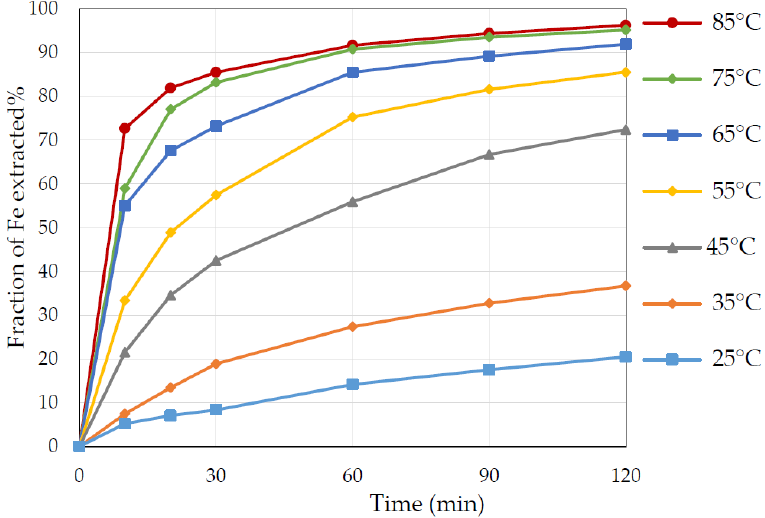
Figure 5. The extraction of iron from pyrite at different temperatures from 25 to 85 °C. Conditions: 3 M nitric acid, S/L ratio 1 to 20, particle size +75 – 106 µm.